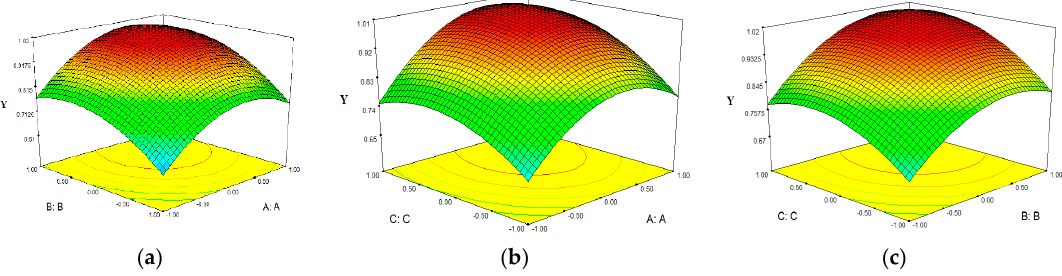
Figure 3. Surface plots illustrating interaction of parameters on oil yields including ( a ) e ff ect of extraction time and water / material ratio; ( b ) e ff ect of extraction time and microwave power; and ( c ) e ff ect of water / material ratio and microwave power.